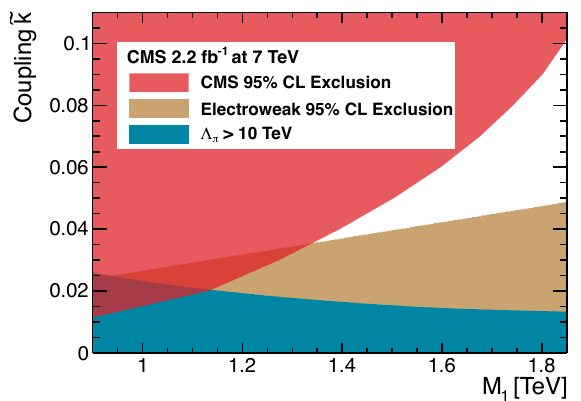
Fig. 2. The 95% CL exclusion region for the RS1 graviton model in the M 1 -˜ k plane. The expected limits coincide very closely with the measured limits and so are not shown in the figure. Also shown are bounds due to electroweak constraints and naturalness ( Λ π > 10TeV). Perturbativity requirements bound ˜ k < 0 . 10.